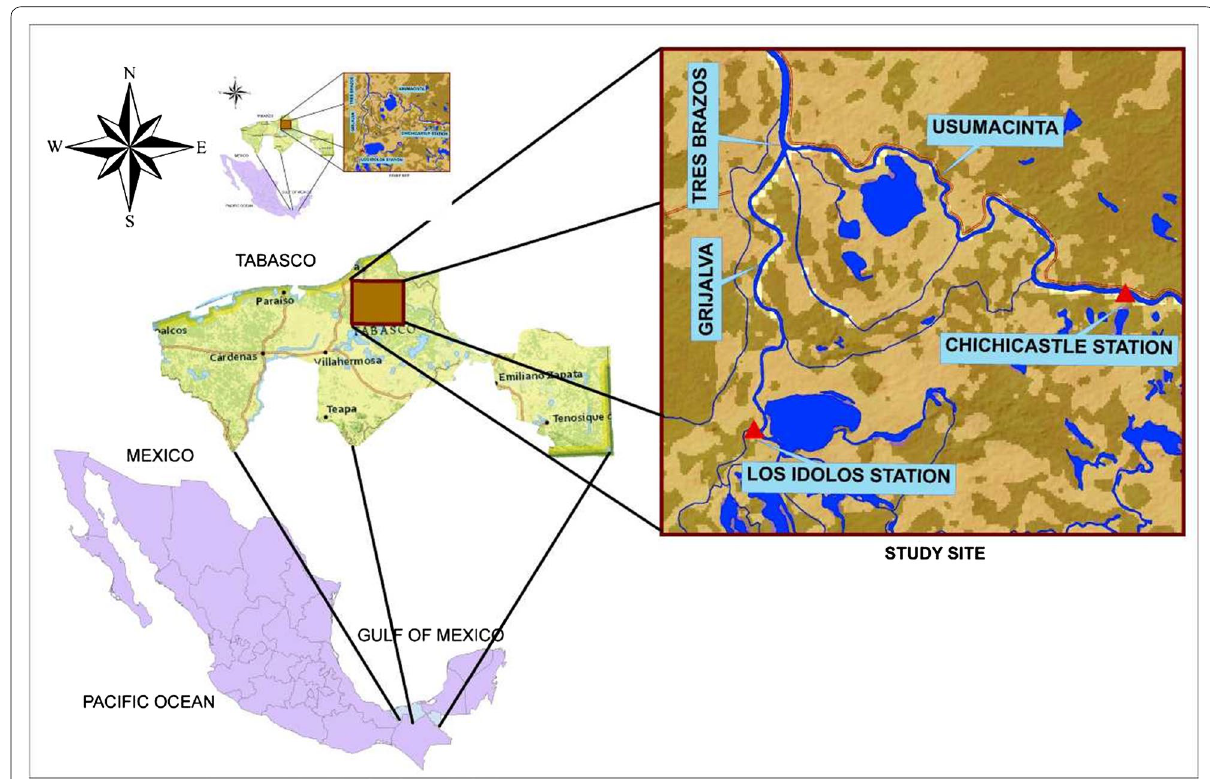
Fig. 1 Location of sampling stations in the Grijalva and Usumacinta